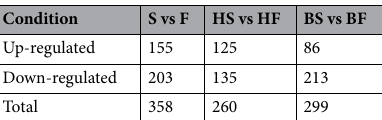
Table 1. Summary of the differentially expressed transcripts between